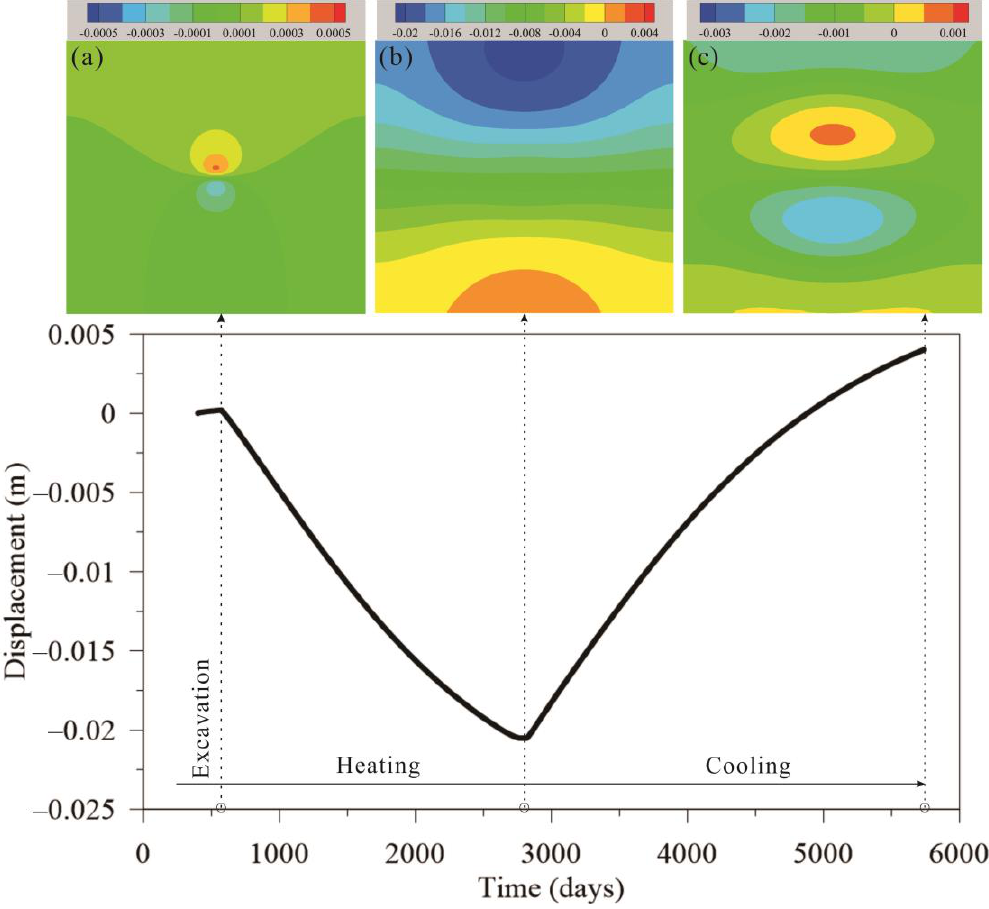
Figure 17. Temporal evolution of vertical deformation at the top of the ALC1604 cell, and also shows spatial distributions of vertical deformation after ( a ) excavation, ( b ) heating, and ( c ) cooling stage.